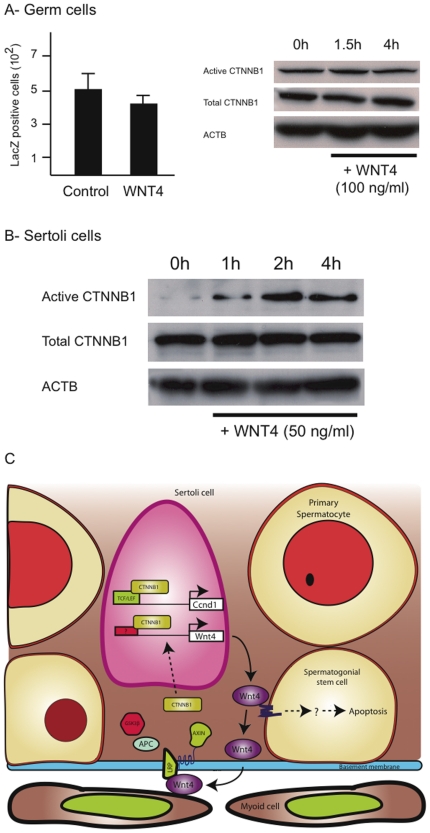
WNT4 acts through canonical and noncanonical pathways in different testicular cell types.(A) Left panel: LacZ-positive cell numbers in cultured germ cells from TCF/Lef-lacZ transgenic mice treated or not beforehand with WNT4 (100 ng/ml). Data is expressed as mean (columns) ± SEM (error bars). Right panel: Timecourse immunoblot analyses of cultured germ cells treated with WNT4 (100 ng/ml). ACTB was used as a loading control. (B) Timecourse immunoblot analyses of cultured Sertoli cells treated with WNT4 (50 ng/ml). ACTB was used as a loading control. (C) Experimental model illustrating WNT4/CTNNB1 signaling mechanisms in Sertoli cells and spermatogonial stem cells.